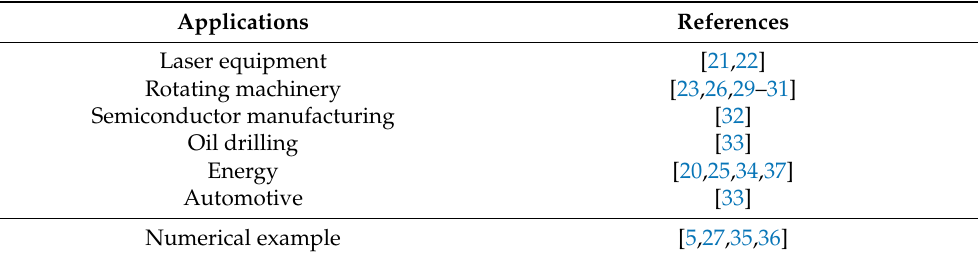
Table 6. Evaluation of cost estimation and maintenance